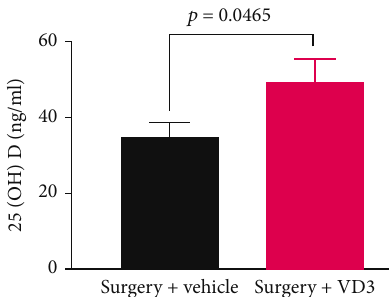
Figure 3: Serum 25(OH)D content following surgery. Data are presented as means ± SD ( n = 6 per